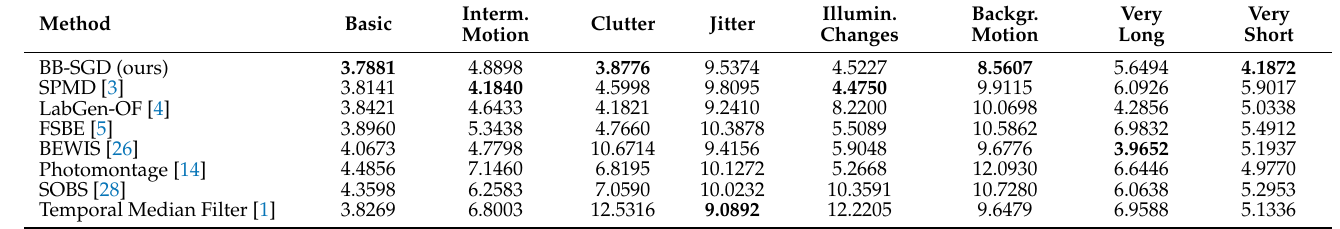
Table 2. Evaluation results for the AGE criterion per category on the SBMnet 2016 dataset. Source: SBMnet website http://pione.dinf.usherbrooke.ca/results/294/ (accessed on 20 November